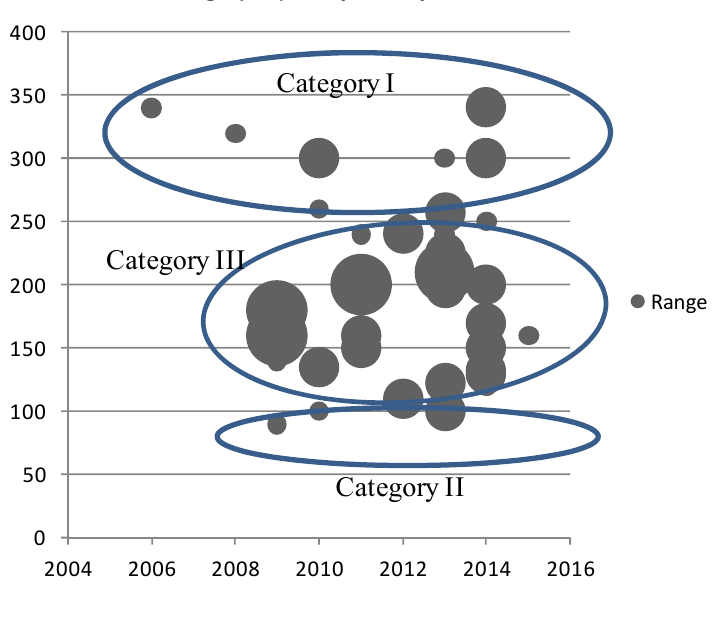
Figure 2. Range categories for fast charge enabled